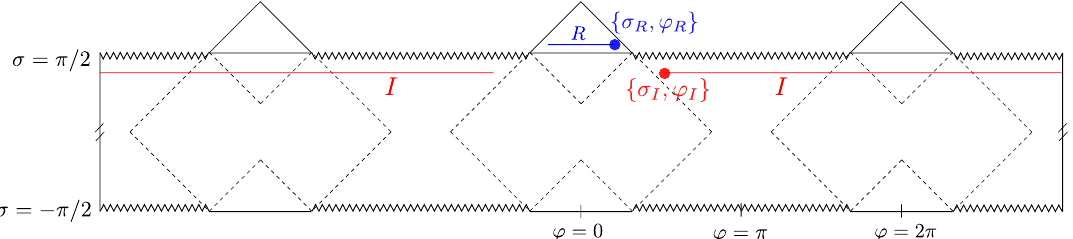
Figure 3. Island region I for entropy of region R in an n = 3 universe. The entropy on the complement of R ∪ I factorizes into the sum of the entropies on the two intervals; the endpoints of one of the two intervals are given by { σ I , ϕ I } and { σ R , ϕ R } as appears in (3.1).